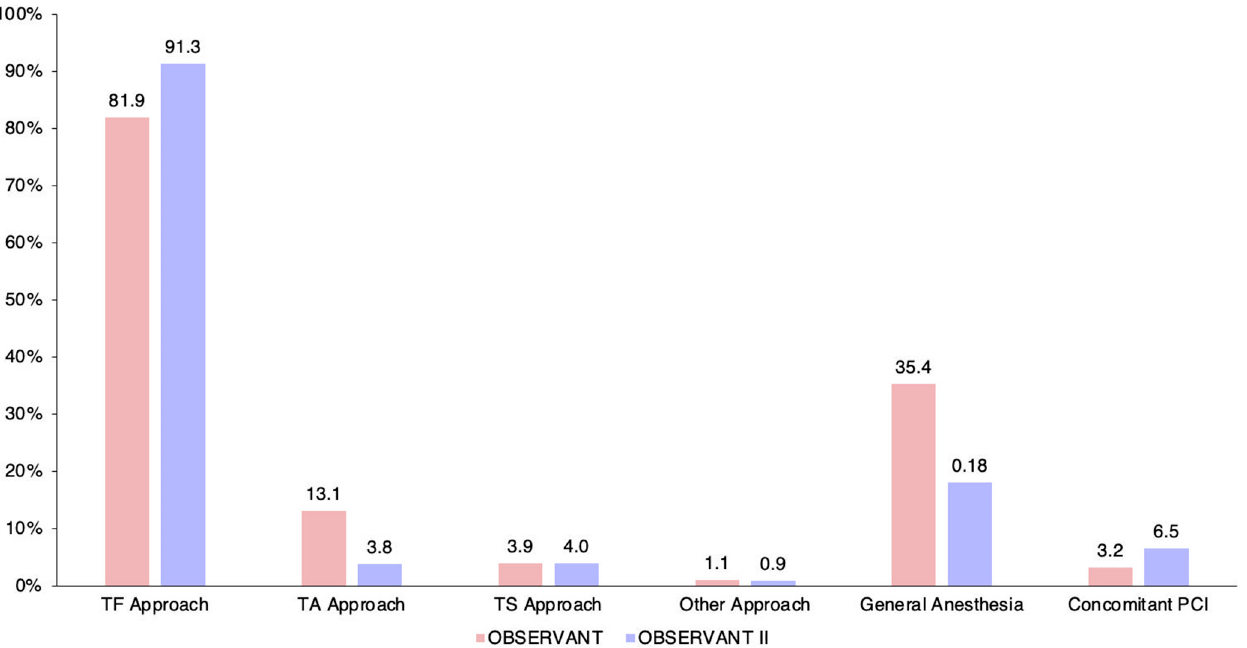
Figure 3. Crude procedural differences of patients undergoing transcatheter aortic valve implantation and enrolled in the OBSERVANT and OBSERVANT II studies. PCI, percutaneous coronary intervention; TA, trans-apical; TF, trans-femoral; TS, trans-subclavian.